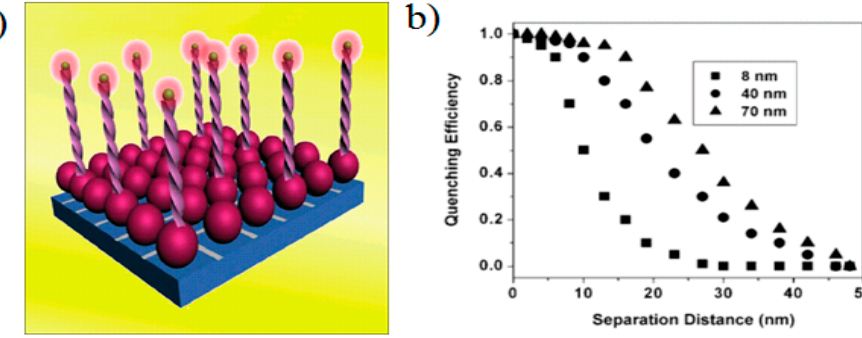
Figure 17. ( a ) Schematic drawing of relationship between NSET’s scale and distance. ( b ) Effect of distance between gold nanoparticle and Cy3 dye on quenching efficiency [85].